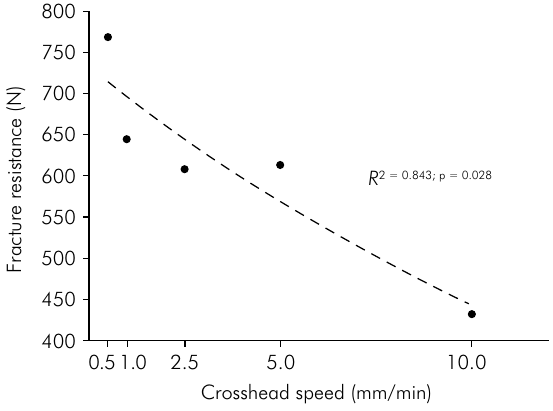
The non-linear regression model was significant (p = 0.028), indicating that an increase in crosshead speed can predict a decrease in the fracture resistance of adhesively restored premolars ( R 2 = 0.843). Figure. Non-linear regression